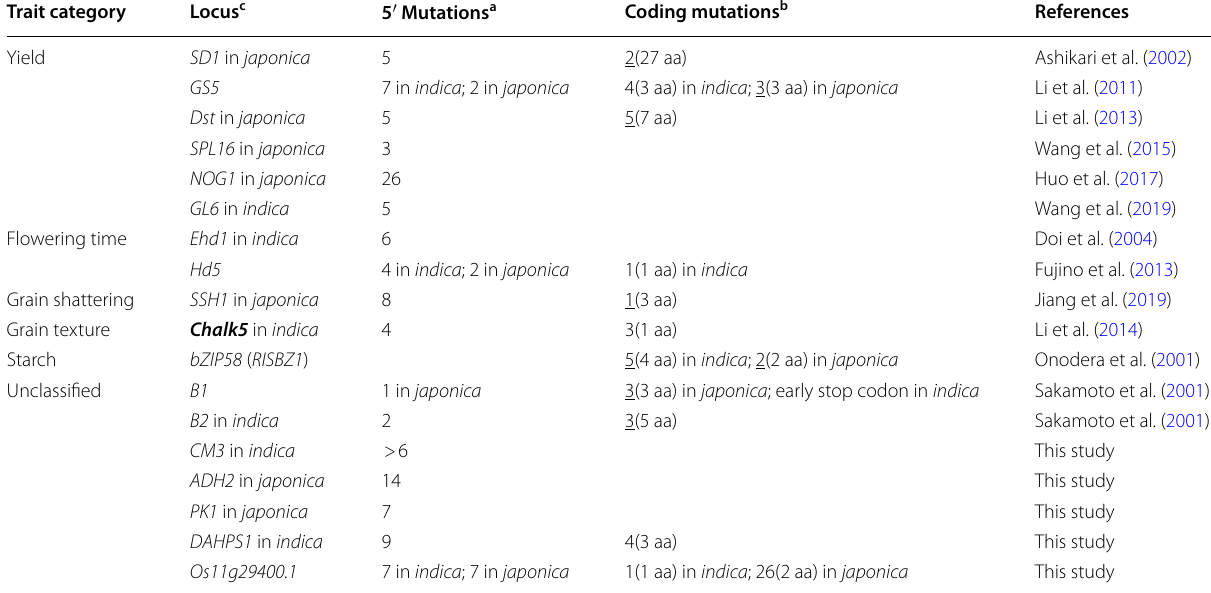
a Mutations shown include both substitutions and indels b All mutations are listed but only those underlined were considered under positive selection. Amino acid (aa) changes introduced by the mutations are in the parentheses c Locus in bold has selected mutation(s) tested functional in at least one